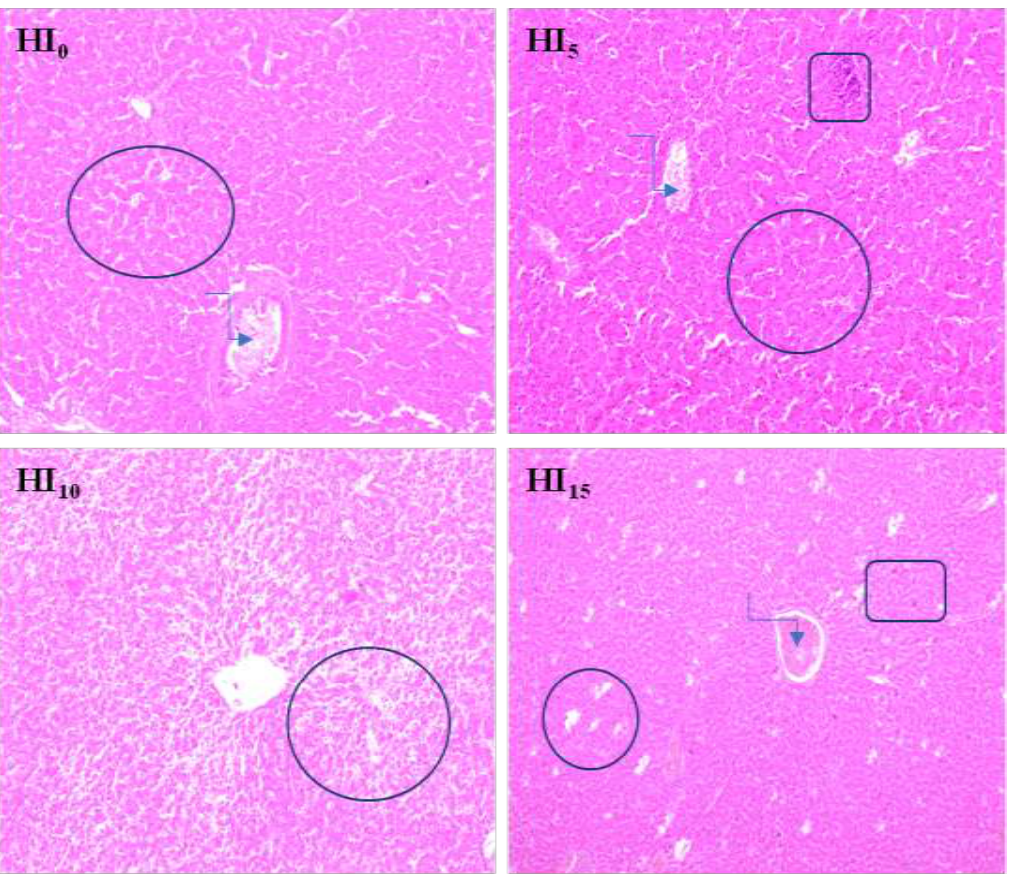
Figure 1. Morphological effects of different HI levels in feed on turkeys liver (magnification 10×). Treatments: HI 0 – group without HI in diet; HI 5 — group with 5% HI in diet; HI 10 — group with 10% HI in diet; HI 15 — group with 15% HI in diet. foci of fatty degeneration; blood stasis in the central vein; local infiltration of mononuclear cells